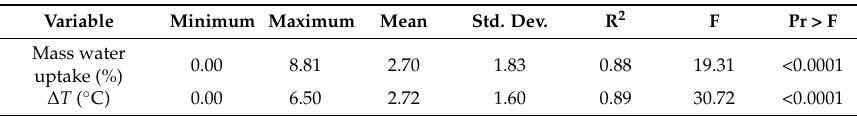
Table 6. Summary statistics for the experimental factorial design performed considering a mean of two